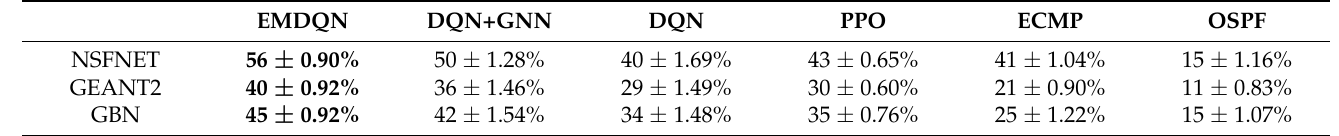
Table 4. A comparison of the average link utilization of each algorithm in different scenarios.